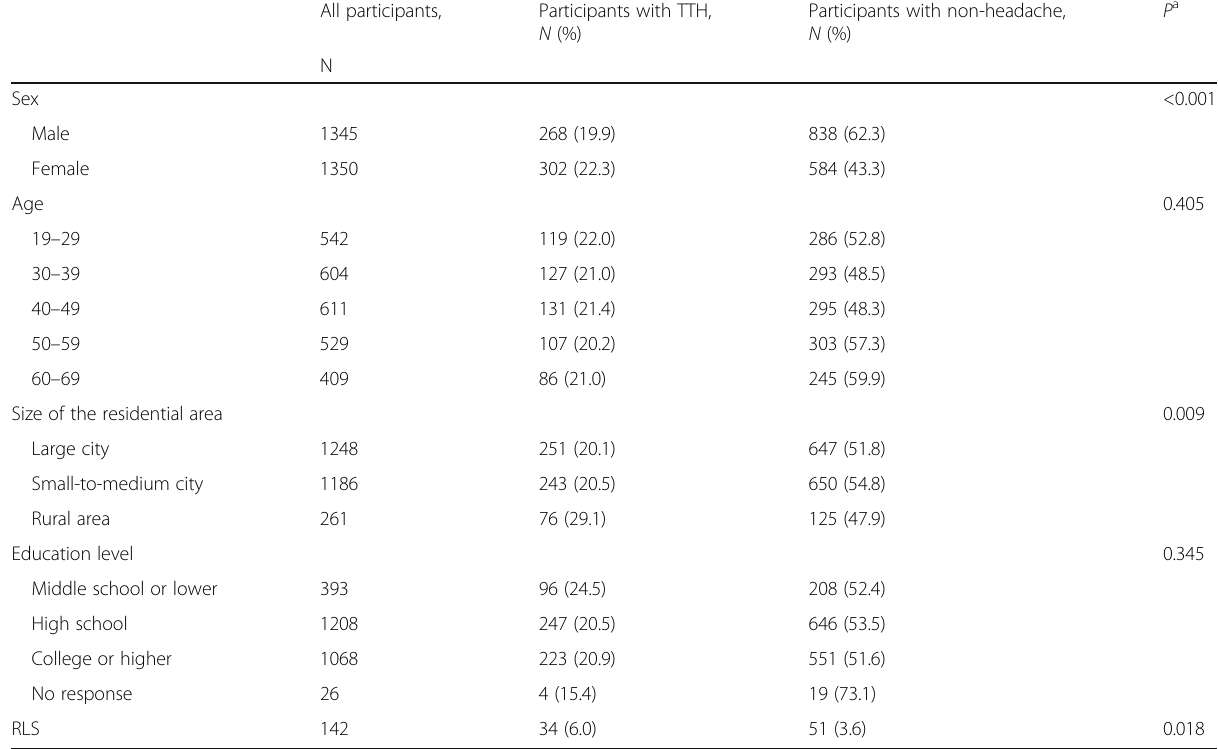
Table 1 Sociodemographic characteristics and RLS status in participants with TTH and participants with non-headache All participants, Participants with TTH, Participants with non-headache, N (%) N (%)